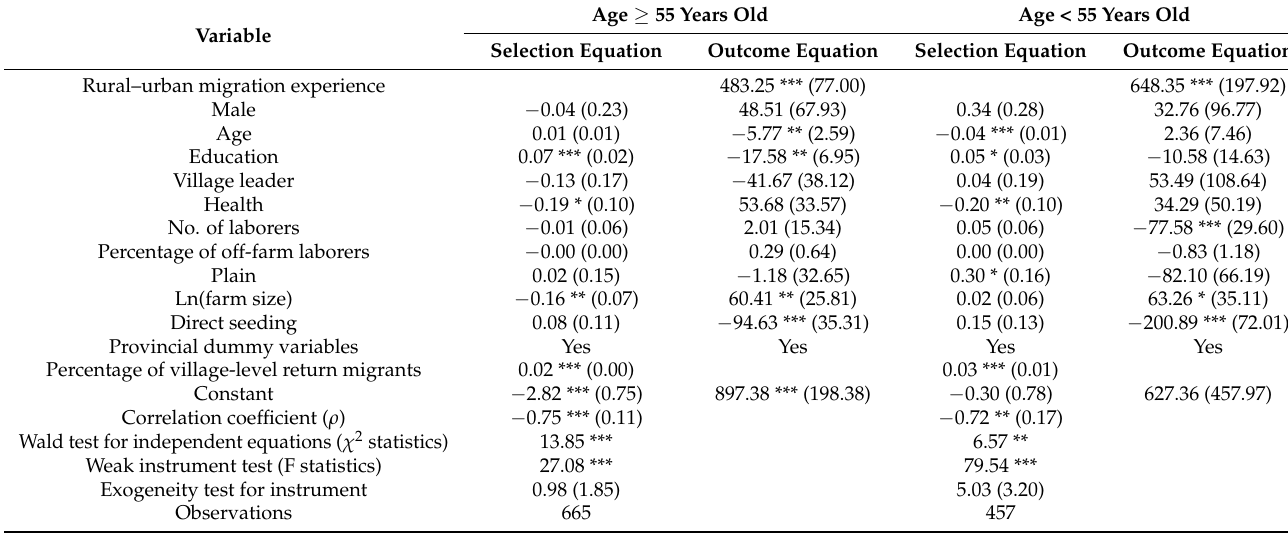
Table 4. Heterogeneity analysis of the impact of rural–urban migration experience on agricultural mechanization by age. Variable Rural–urban migration